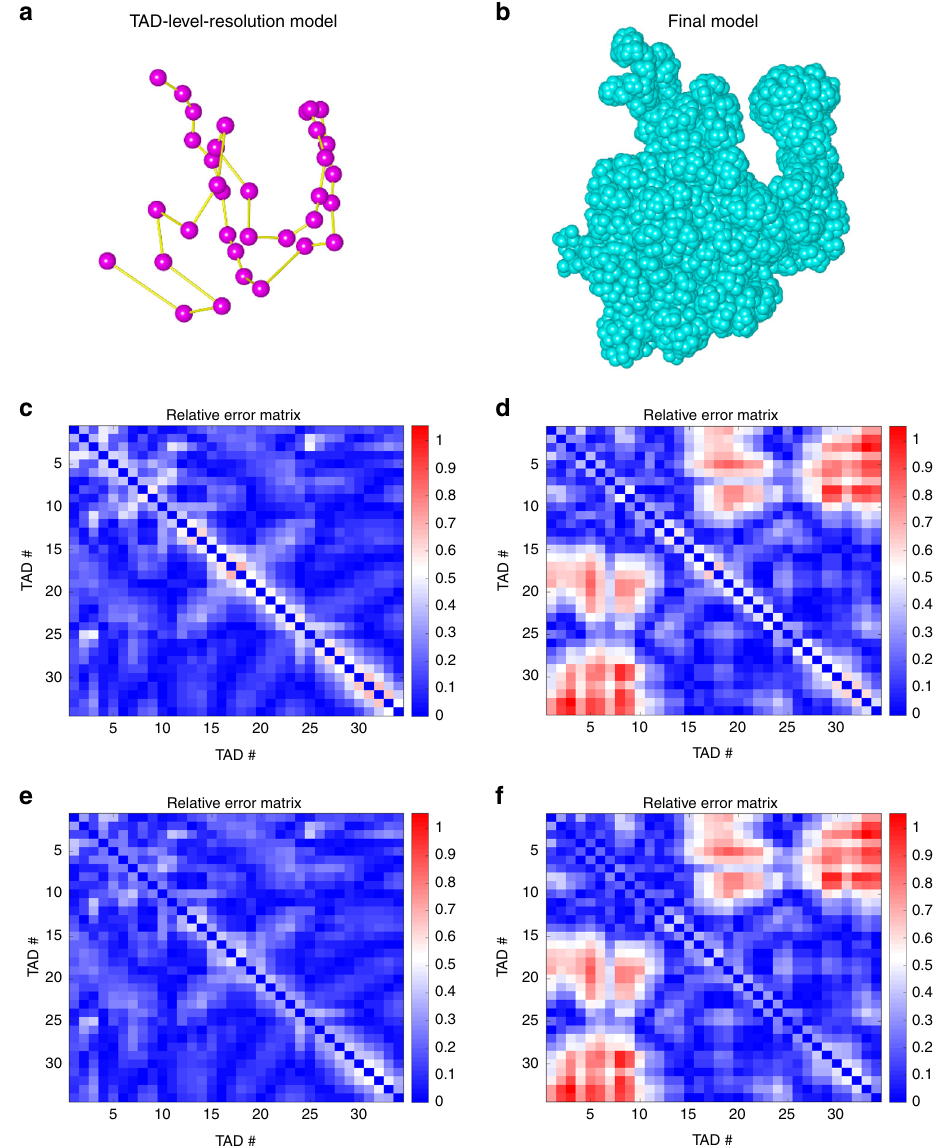
Fig. 2 The modeling results of human Chromosome 21 (Chr21). a The TAD-level resolution 3D structure of Chr21 calculated by GEM-FISH, where each dot represents the center of a TAD. b The fi nal 3D structure of Chr21 reconstructed by GEM-FISH. The visualization in ( a ) and ( b ) was performed using UCSF Chimera 61 . c , d The relative error matrices of the TAD-level resolution models computed by GEM-FISH using both Hi-C and FISH data, and by GEM using only Hi-C data, respectively. e , f The relative error matrices of the fi nal models computed by GEM-FISH using both Hi-C and FISH data, and GEM using only Hi-C data,